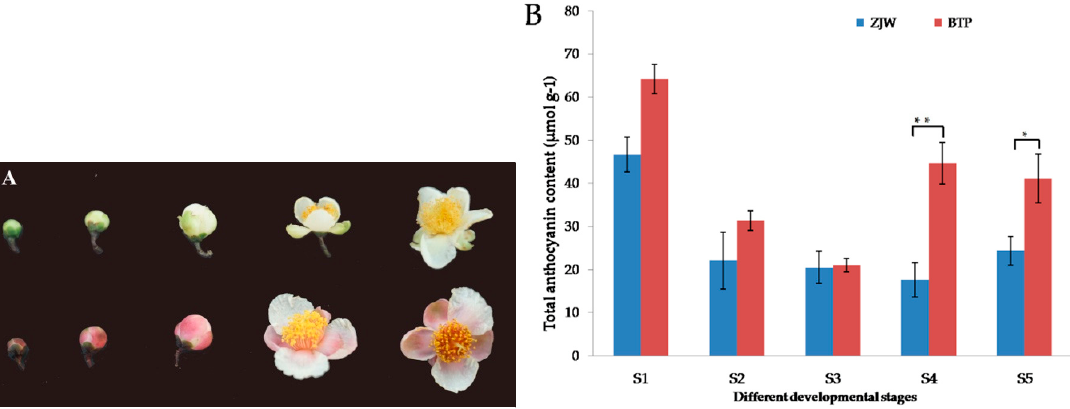
Figure 1. Color phenotypes and anthocyanin contents of white (ZJW) and pink (BTP) flowers during 5 developmental stages (S1–S5). ( A ) The phenotypes of five development stage of ZJW (white) flower and BTP (pink). ( B ) Anthocyanin content ( µ mol / g fresh weight) of white flower (ZJW) and pink flower (BTP) samples. S1, mature flower bud; S2, pre-opening; S3, initial opening; S4, half bloom; S5, full bloom. Each data is the mean of three biological replicates. * p < 0.01; ** p < 0.05.